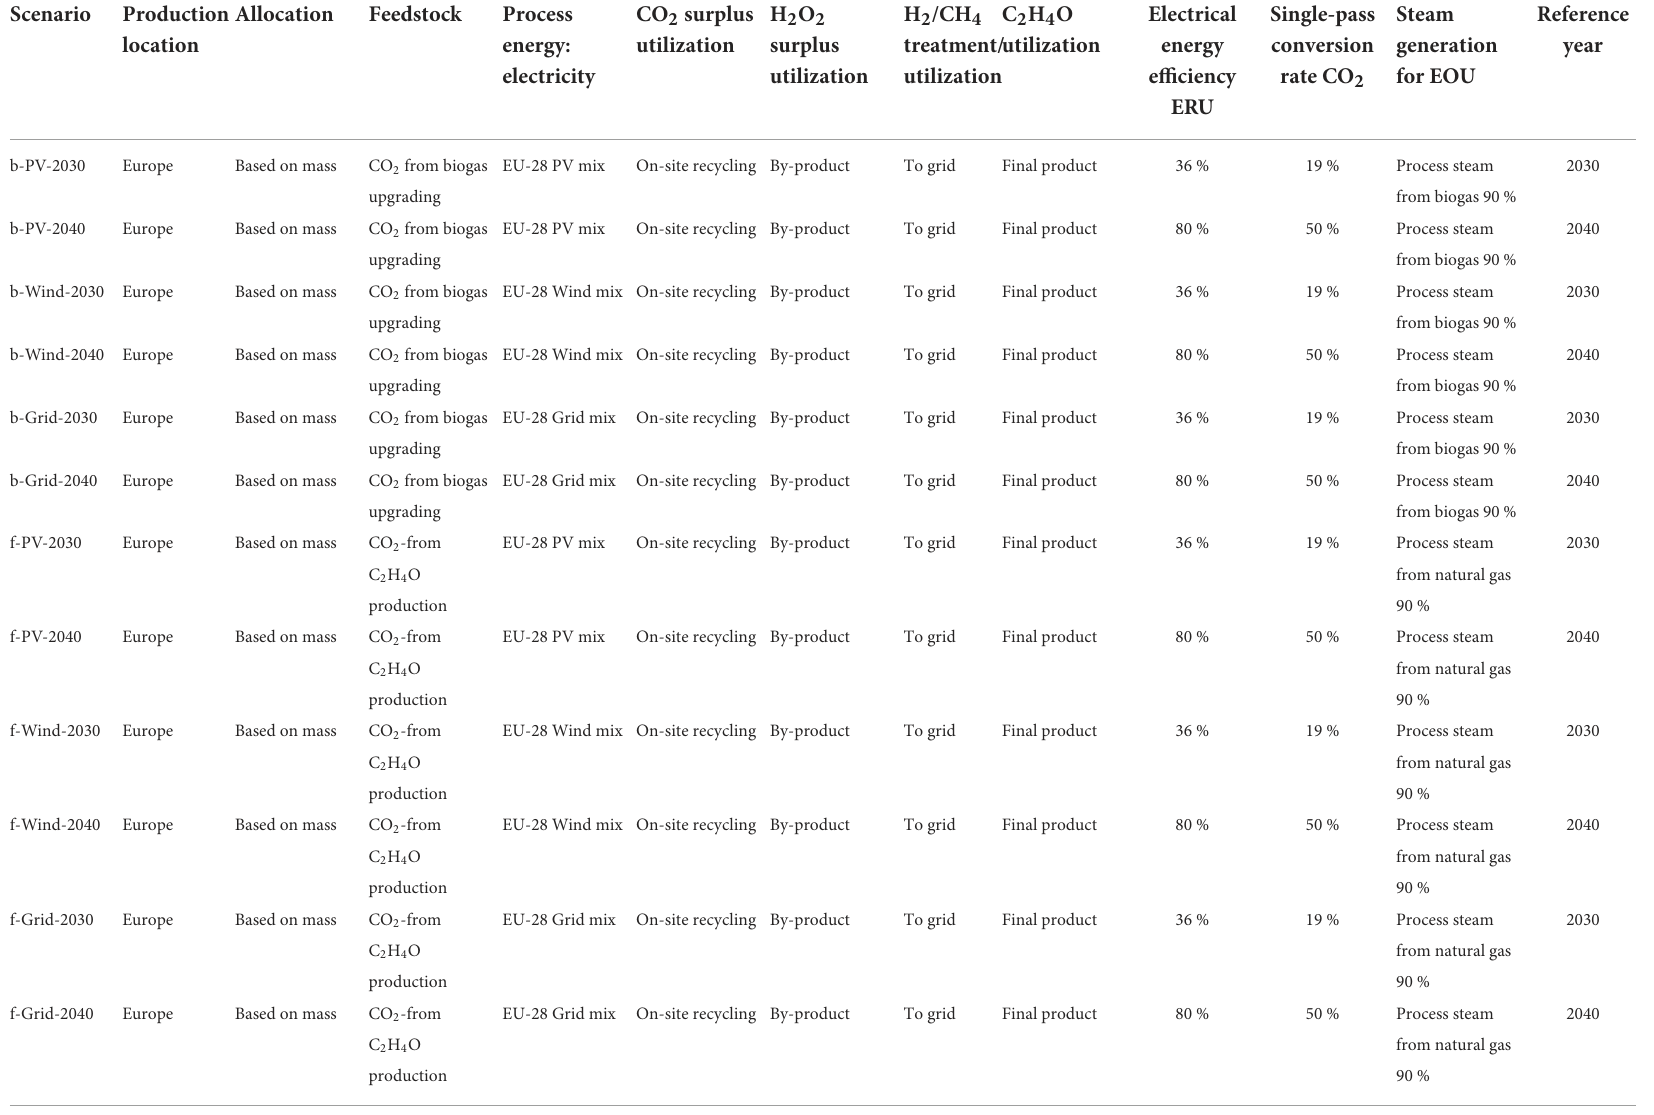
TABLE 2 Scenarios of the analyzed plant under different conditions using biobased and fossil CO 2